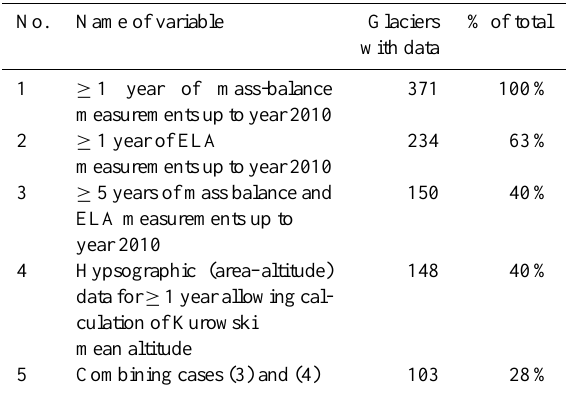
Table 2. Available surface mass-balance data for the present anal- ysis from WGMS (www.wgms.ch/products_fog.html) and some other